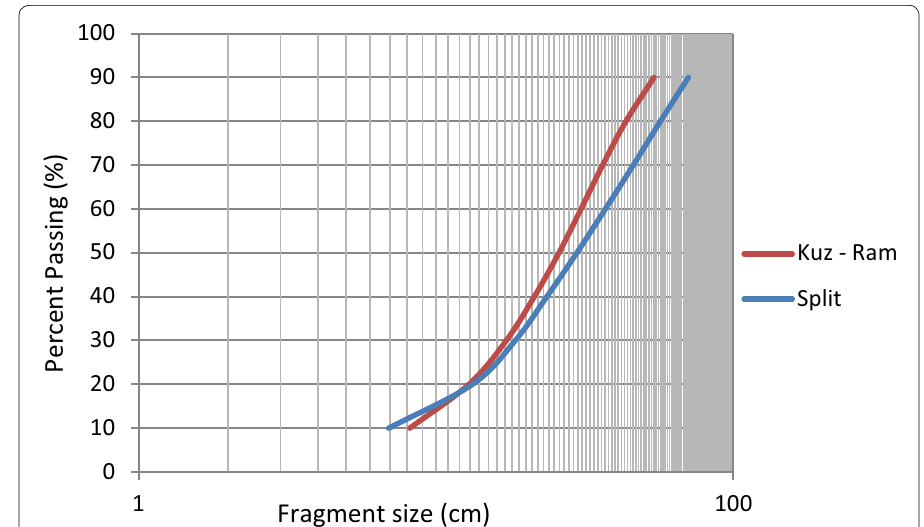
Fig. 5 Diagram obtained from the Kuz-Ram experiential model and digital image analysis in Split Desktop for pattern No. 2